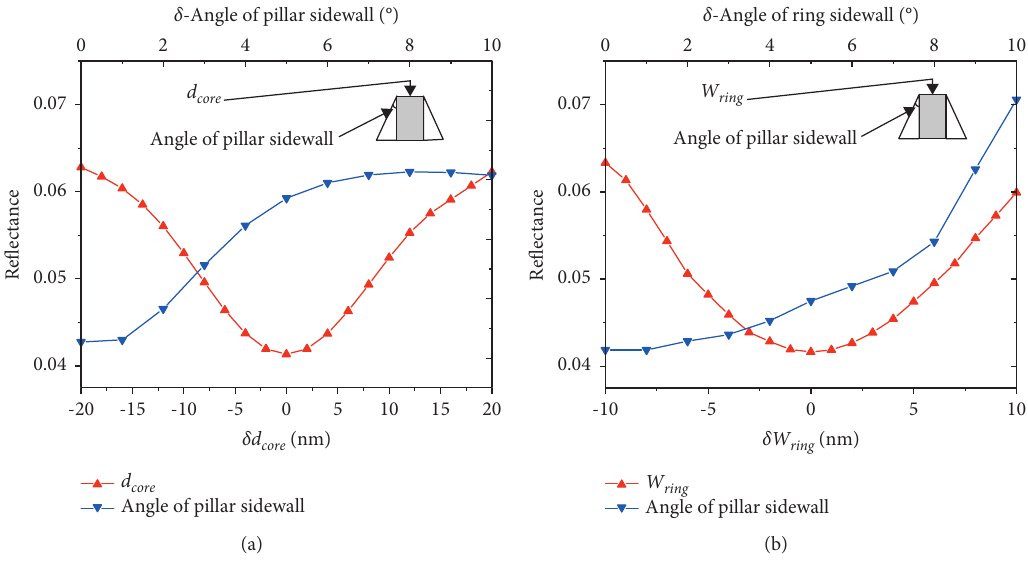
Figure 4: Effect of fabrication variations of the middle pillar (a) and outer ring (b) on the